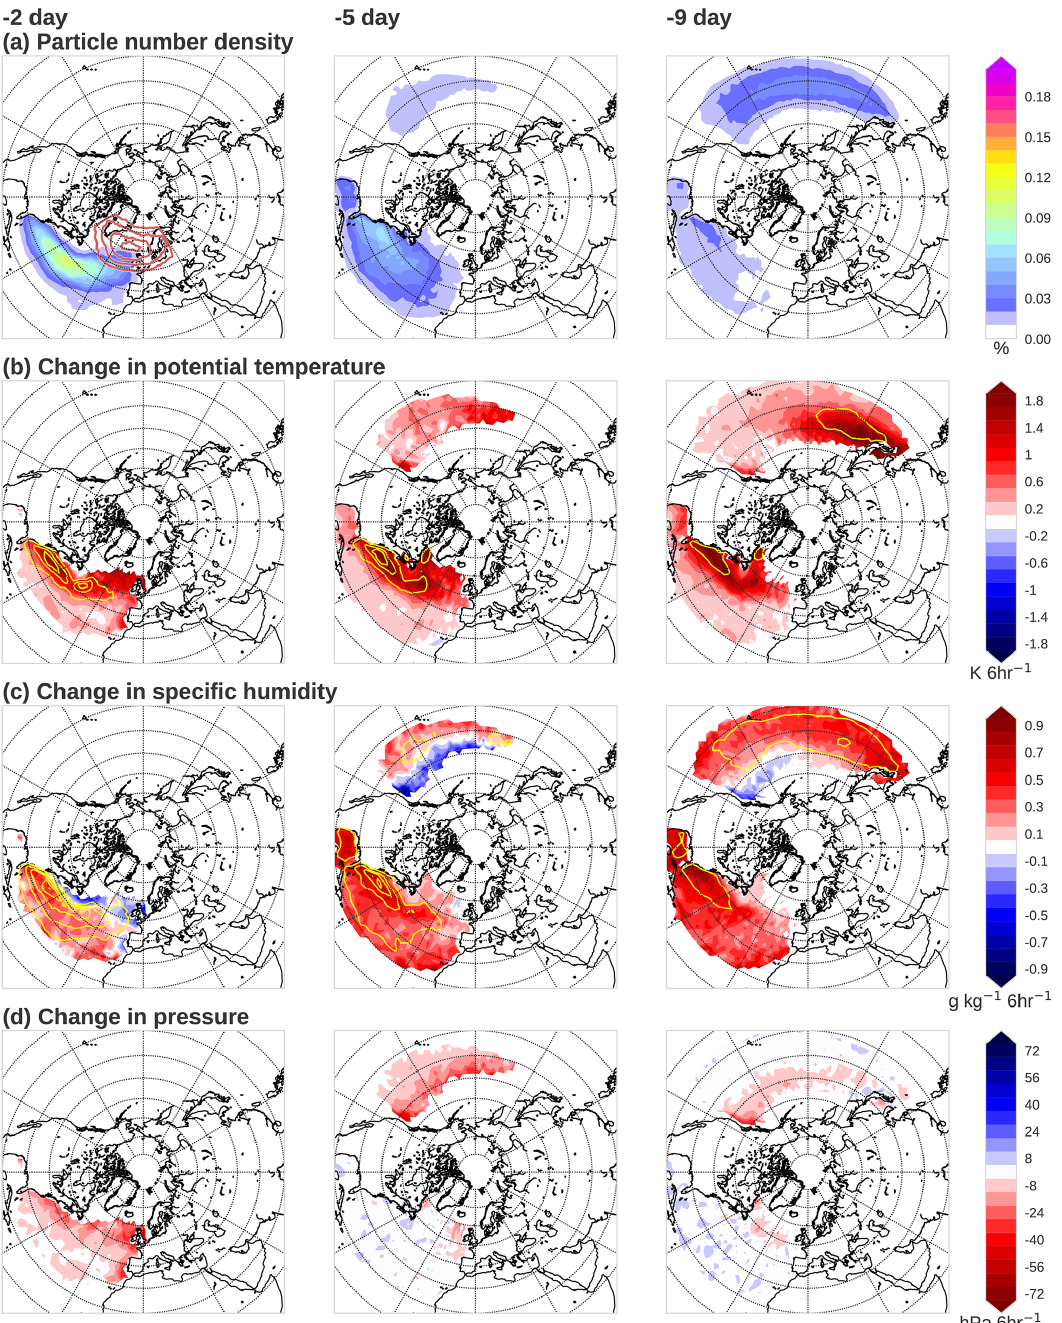
Figure 3. Properties along moist particles when they are located within the marine PBL at 2d (left column), 5d (middle column), and 9d (right column) prior to their arrival at the Euro-Atlantic blocks. (a) Number density of the particles [%] for each 2 ◦ × 2 ◦ grid cell, with their release locations being indicated by the red contours with the interval of 0.05% starting from 0.1%. (b) Mean change in potential temperature (colour shading) along the moist particles when they are situated over each 2 ◦ × 2 ◦ grid cell [K6h − 1 ], with SHF (yellow contours indicating 0.05, 0.15, and 0.25Wm − 2 ) superimposed. (c) Same as (b) but for the mean change in specific humidity (colour shading) [gkg − 1 6h − 1 ] with LHF overlaid (yellow contours for 0.1Wm − 2 with the interval of 0.2Wm − 2 afterwards). (d) Same as (b) but for the mean change in atmospheric pressure [hPa6h − 1 ]. For (b–d) , only those grid cells that contain over 0.005% of the total particle’s 6-hourly density are plotted. SHF and LHF are computed as the total SHF and LHF along moist particles found within each 2 ◦ × 2 ◦ grid cell on the specified days divided by the total number of moist particles, thereby indicating the average SHF or LHF contributing to blocking per particle on each day. Parallels are plotted for every 10 ◦ , whereas meridians are plotted for every 30 ◦ on each